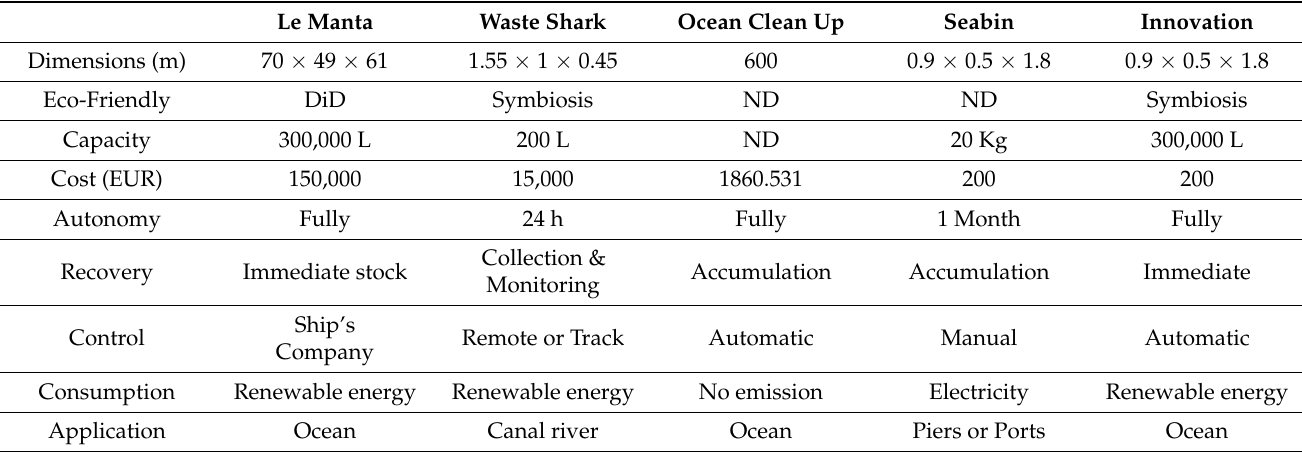
Figure 4. Main solutions for collecting marine plastic pollution on the market: ( a ) WasteShark ; ( b ) Seabin ; ( c ) OceanCleanUp ; ( d ) Le Manta . Table 3. Benchmarking Matrix.